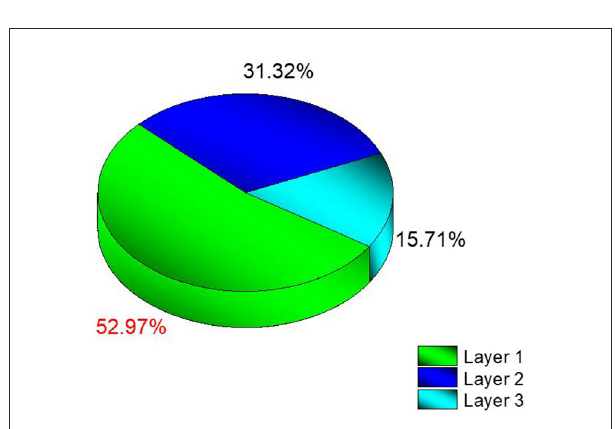
FIGURE7 Average deposited energy amount (%) in different breast layers.